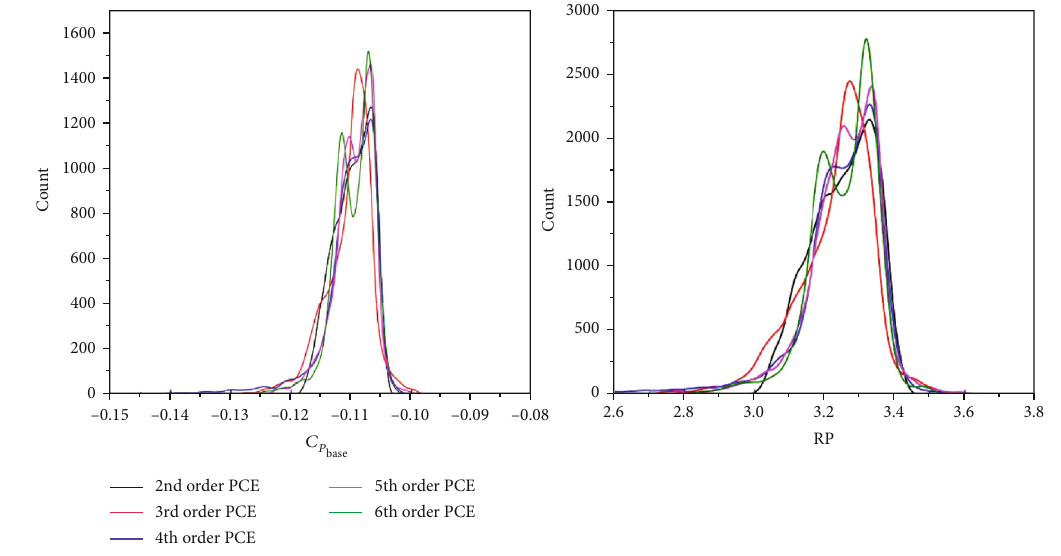
Figure 13: C and RP histogram according to the order of polynomial chaos. P base Table 10: p , ϵ , and Sobol indices of model coe ffi cients with respect to QoIs. LOO